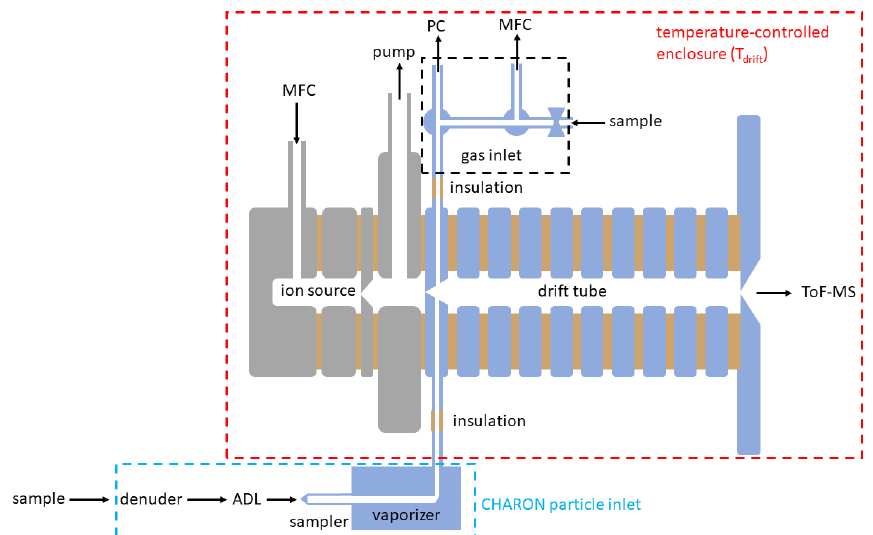
Figure 1. Scheme of the EVR PTR-MS instrument including a gas inlet and the CHARON particle inlet. The parts in blue were passivated with a functionalized hydrogenated amorphous silicon coating. MFC: mass flow controller; PC: pressure controller, ADL: aerodynamic lens; ToF-MS: time-of-flight mass spectrometer.